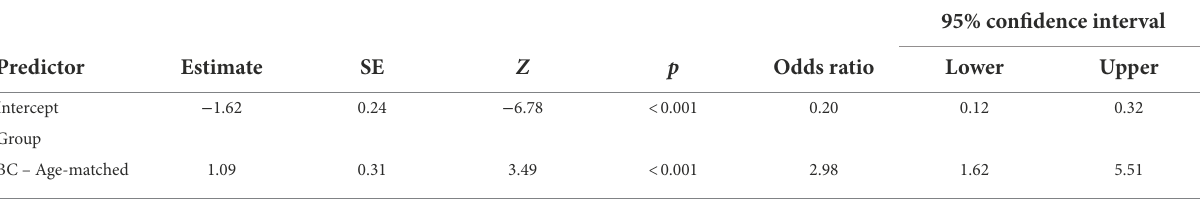
TABLE 2 Binomial logistic regression model for subjective cognitive complaints (SCC). Model coefficients – subjective cognitive